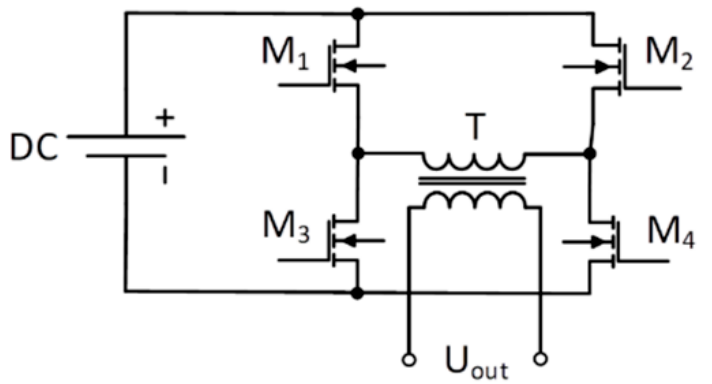
Figure 6. Full-bridge converter schematic. Energy is transferred to the transformer in very short pulses only when a pair of opposing transistors are turned on (Figure 6—M1–M4 and M2–M3). The duration of these pulses is fixed, which ensures that the energy supplied to the transformer will always be constant. Meanwhile, the value of the current in the primary winding is regulated by the dead time, i.e., the time in which energy is not supplied to the transformer. The disadvantage of using transformers with a large parasitic capacitance is that large current distortions can occur in the primary winding when using phase-shifted control (Figure 7). This will cause problems with controlling the current and increase the losses in the windings, making this method difficult to